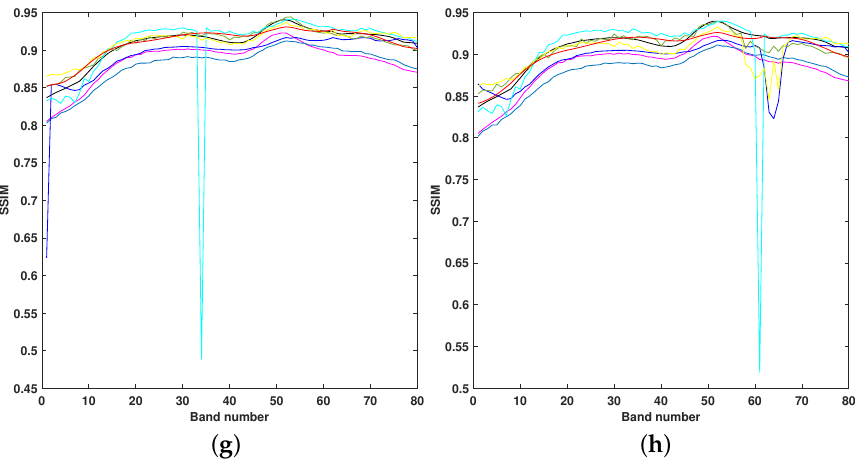
Figure 6. The SSIM values of each band in dataset-1 after denoising by eight different methods under ( a ) case 1, ( b ) case 2, ( c ) case 3, ( d ) case 4, ( e ) case 5, ( f ) case 6, ( g ) case 7, ( h ) case 8.